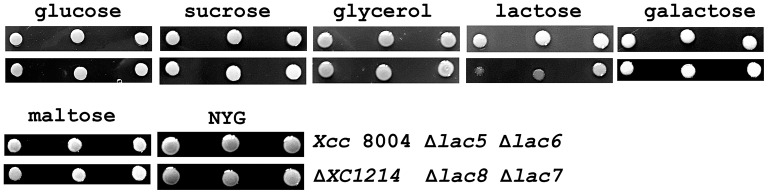
The sugar usage of the GH2 and GH35 mutants in Xcc 8004. The growth of the indicated strains (right end panel) on solid plates when the individual sugars were used as the sole carbon source. Δlac5: ΔXC1003/ΔXC2985/ΔXC4208/ΔXC2481/ΔXC1708; Δlac6: Δlac5/ΔXC4194; Δlac7: Δlac6/ΔXC1218; Δlac8: Δlac7/ΔXC1214.